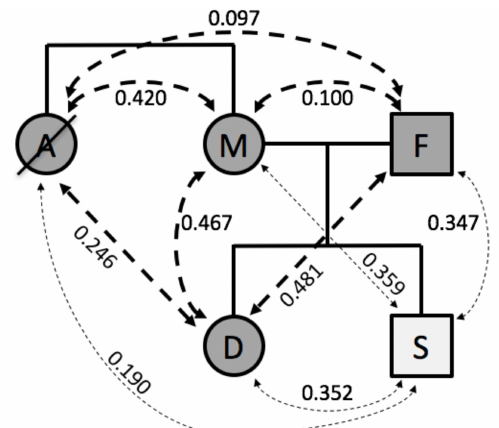
Figure 2. Comparison within a family of five. A: Aunt (deceased); M: Mother; F: Father; D: Daughter; S: Son. Dashed lines represent family relationships; thin lines denote comparison between individuals assayed on different versions of the genotyping